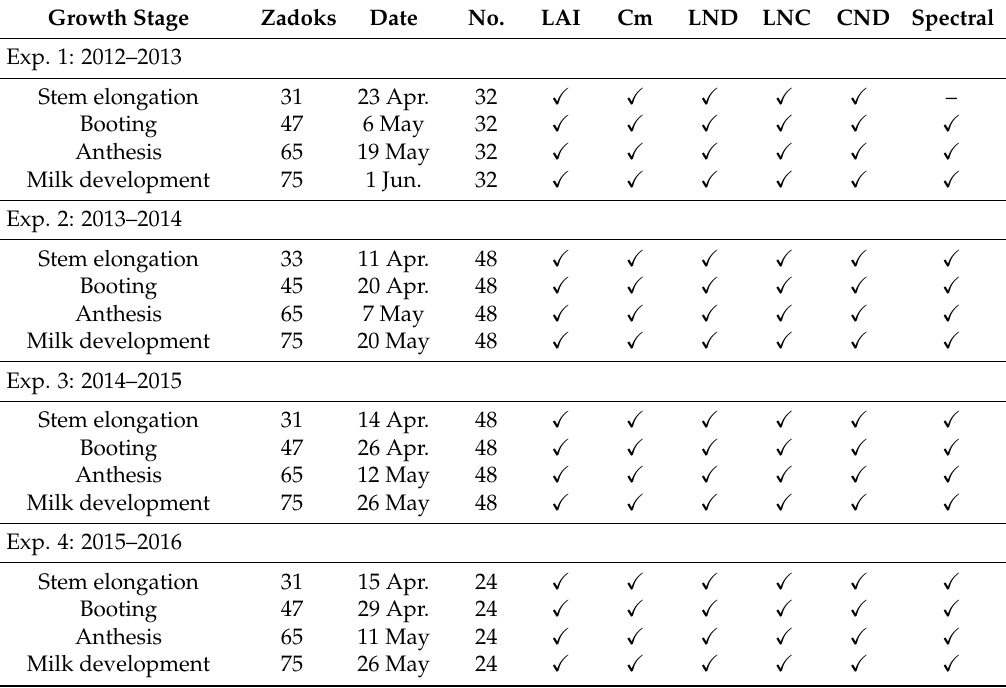
Table 2. List of acquired experiment data in the four wheat